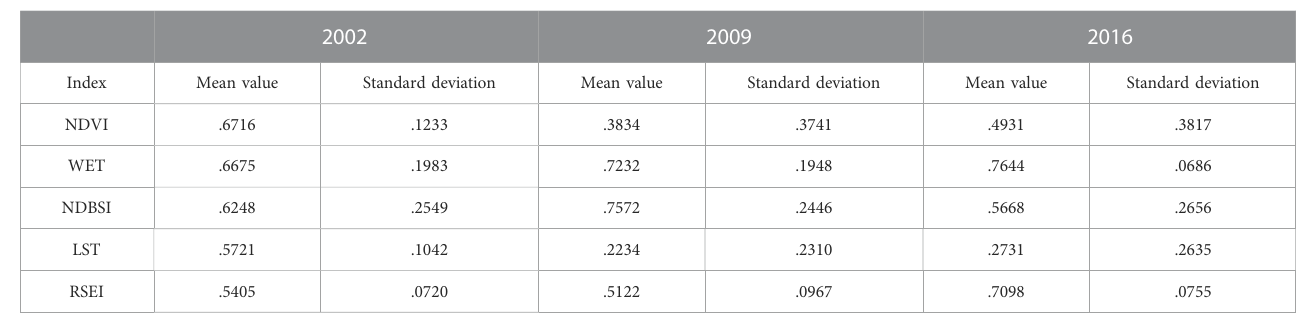
TABLE 3 Four indicators and RSEI statistics in 2002 and